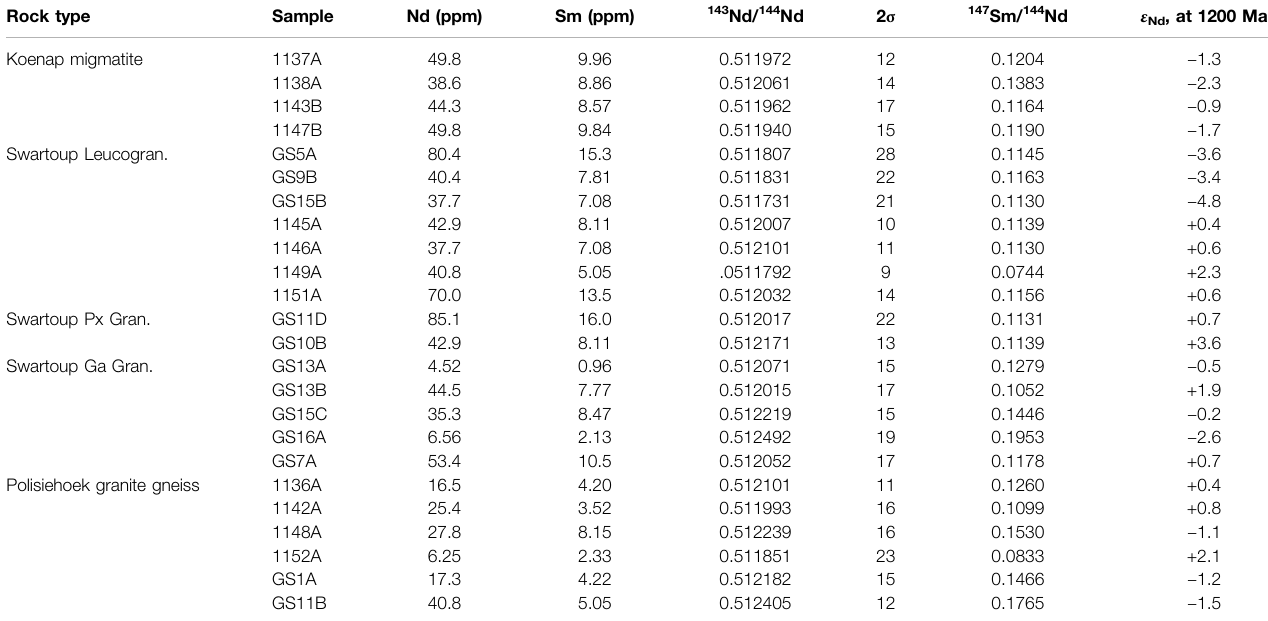
TABLE 3 | Radiogenic isotopic for the Swartoup Hills. (Sm – Nd isotopic compositional data). Rock type Sample Koenap